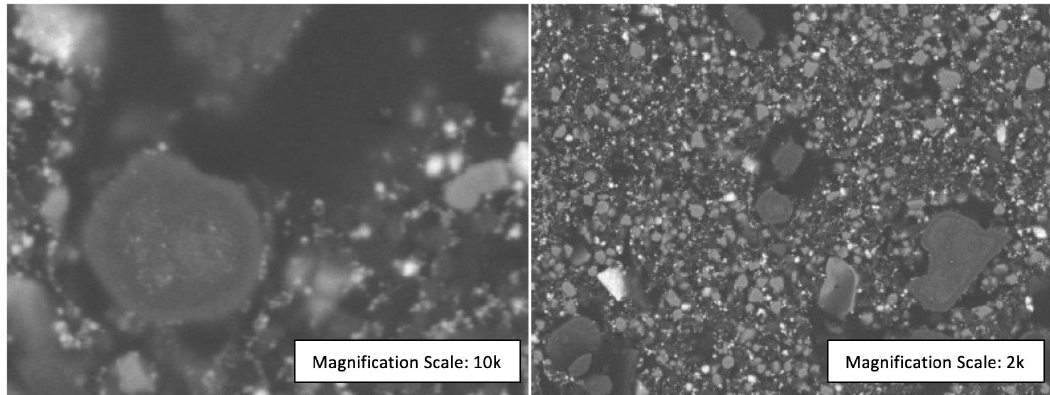
Figure 11. Micrograph of sample of 50%aluminum oxide 50% CRFO powder, with magnification of (a) 10,000x and (b) 2000x.